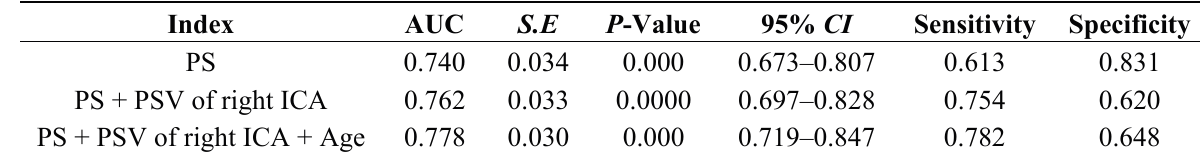
Table 3. ROC prediction curve of each index of coronary heart disease.